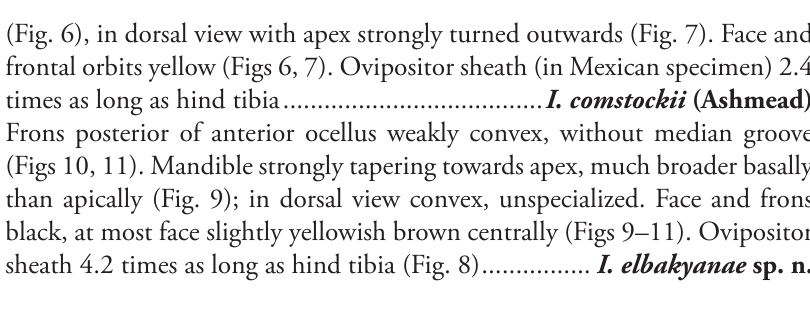
Comparison. The new species differs from all Nearctic species by the occipital carina absent dorsally and laterally (Figs 10, 11); the mandible strongly tapering apically (Fig. 9), in dorsal view unspecialized, convex (turned outwards in other species except I. eu- ryops – as in Fig. 7); and the entirely black frons (Figs 10, 11). In addition, I. elbakyanae differs from the three species occurring in the Palaearctic region (Kasparyan and Tolkanitz 1999) by its extremely long ovipositor, shorter first tergite, strongly tapered mandibles and dorsally absent occipital carina (in I. euryops this carina is sometimes weak or vestigial mediodorsally); it also differs from I. alysiina and I. euryops by the head, in dorsal view, with long and prominent genae; and from I. eurum and I. euryops by the fuscous face (yellow in the two other species). Description. Female . Body length 3.8 mm. Fore wing length 3.9 mm. Head prominent, strongly rounded behind eyes in dorsal view (Fig. 10); gena 1.1 times as long as eye width. Ocellar index 1.8. Clypeus very broad and short, separated from face by deep and sharp groove, with upper margin somewhat convex medially and lower margin slightly concave (Fig. 9), strongly convex in lateral view. Mandible strongly tapered in basal half, 2.6 times broader basally than apically (at level of base of teeth), with raised flanges on lower and upper margins; upper tooth longer than the lower; mandible in dorsal view convex, unspecialized. Malar space very short, upper corner of mandible almost touching eye margin (Fig. 9). Antennal flagellum slender, slightly tapered towards apex, with 23 flagellomeres; flagellomere 1 slightly